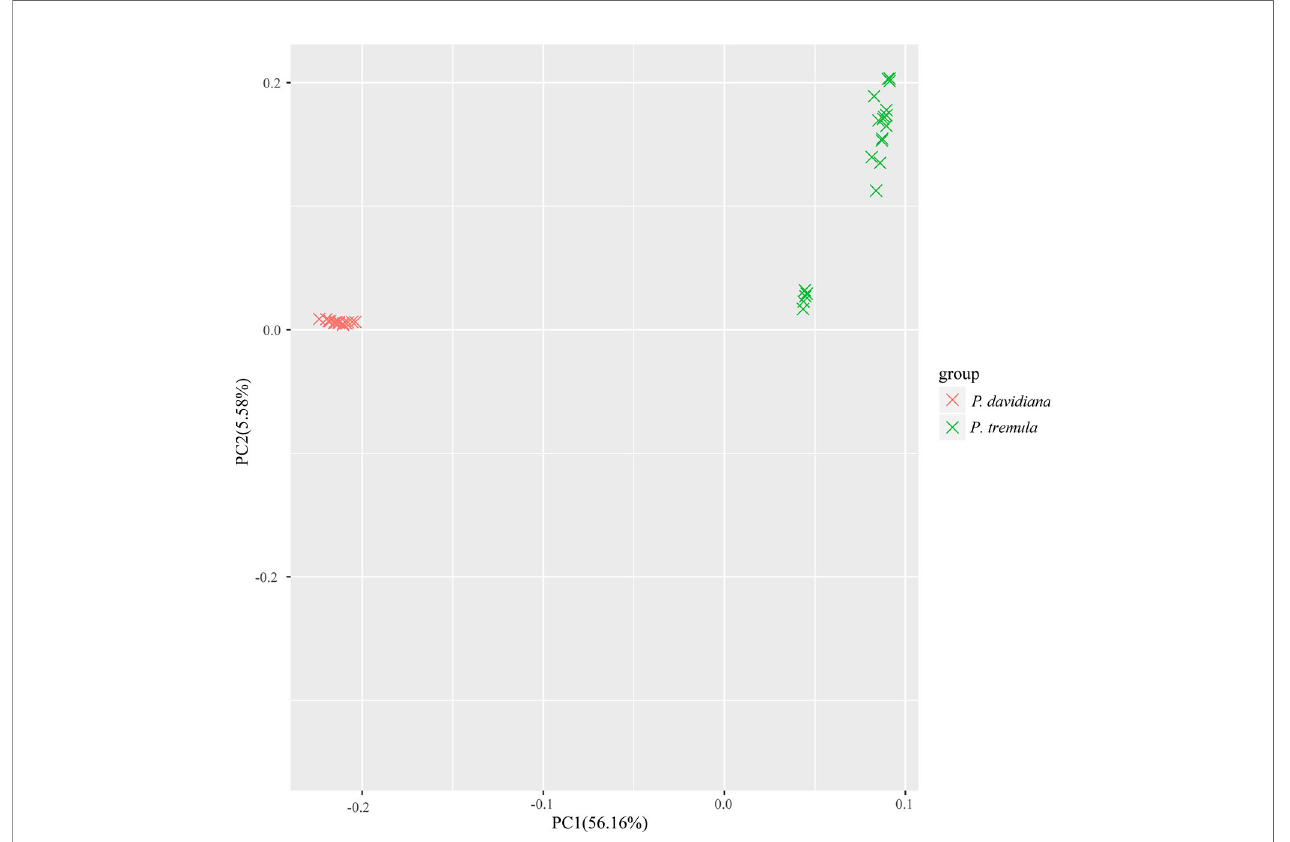
FIGURE 3 | Principal component analysis (PCA) plot based on genetic covariance.